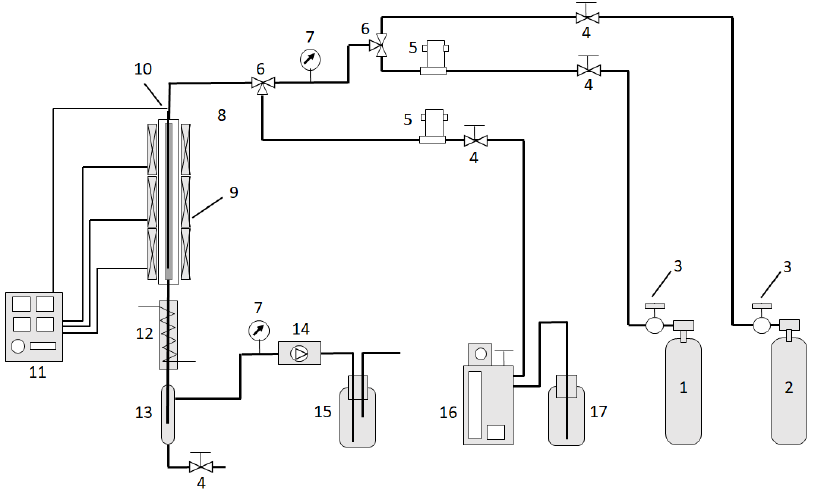
Figure 9. Fixed-bed reaction system. 1–H 2 ; 2–N 2 ; 3–Reducing valve; 4–Valve; 5–Mass flow meter; 6–